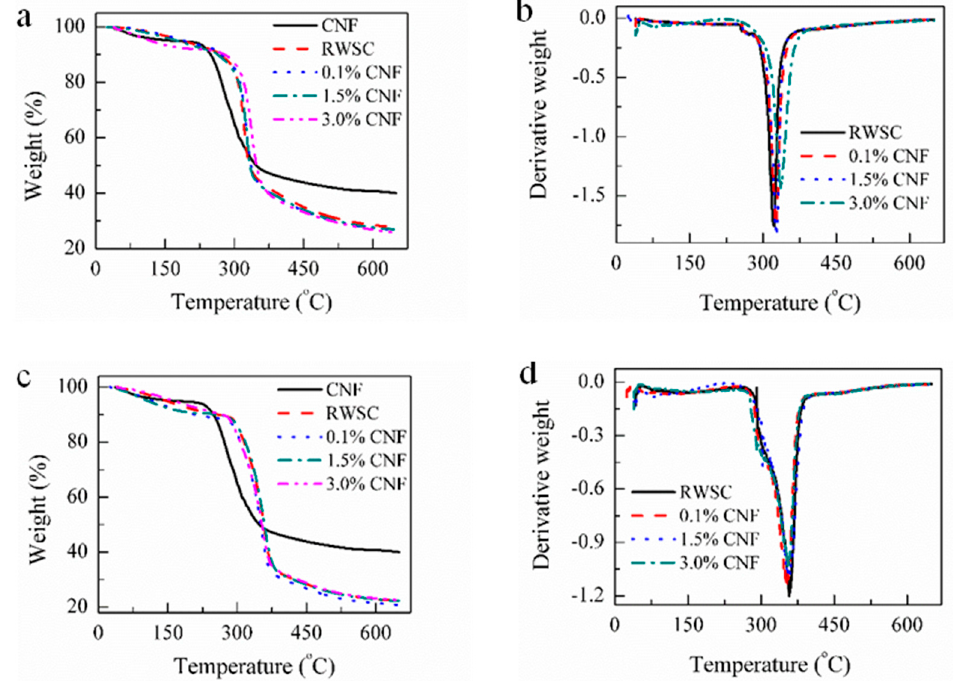
Figure 9. TGA and DTG curves of the CNFs, RWSC, and all-cellulose nanocomposite: ( a , b )